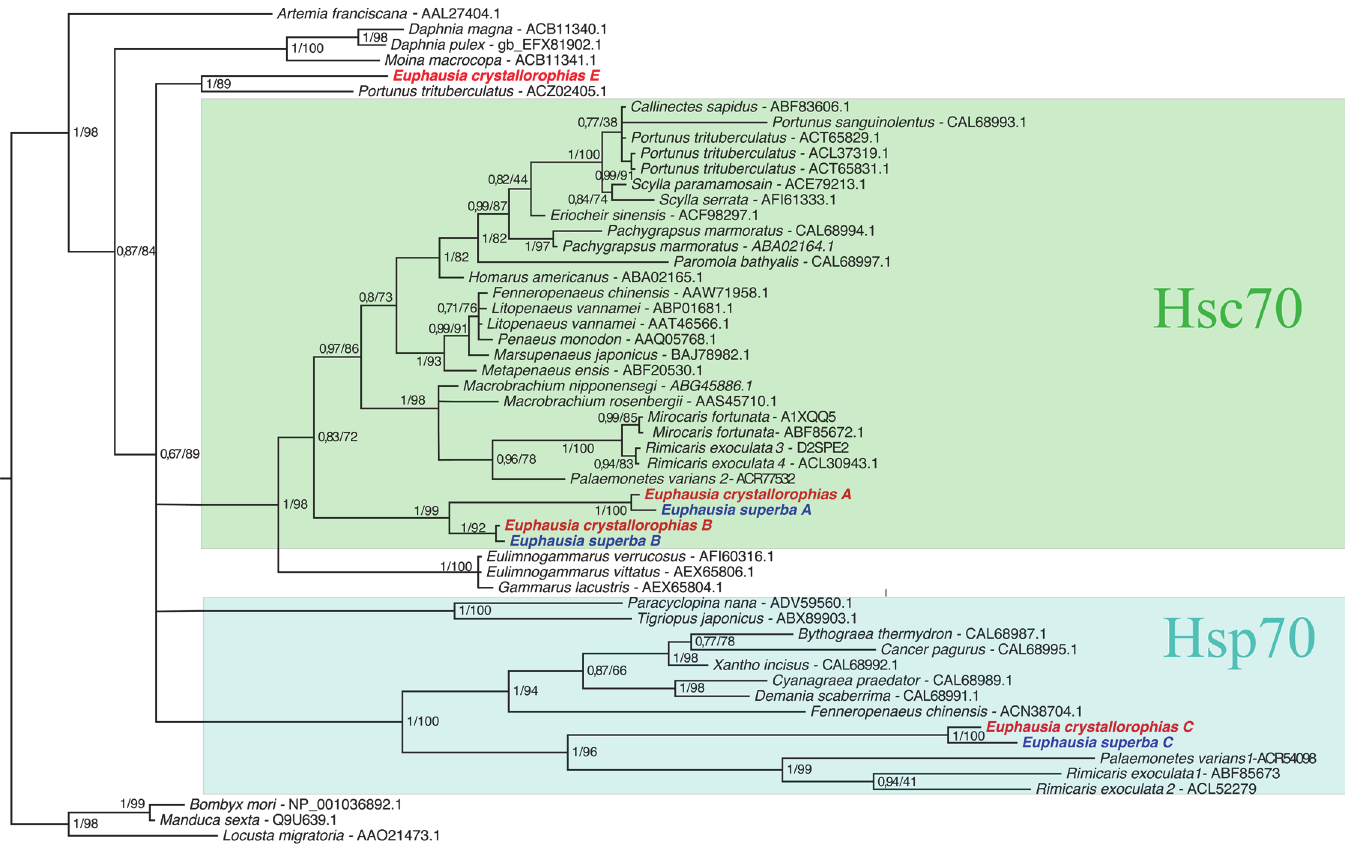
Fig 3. Phylogeny of the HSP70 family in Eucrustacea based on Maximum Likelihood and Bayesian analyses of amino acid data set. Numbers above branches are posterior probabilities and bootstrap values (based on 100